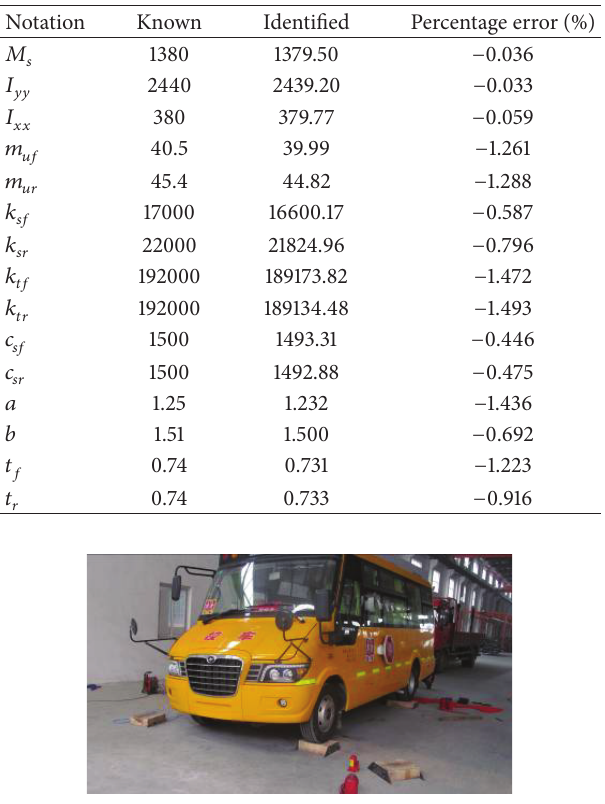
Table 2: Comparison of the parameters of identification with the ones of vehicle.